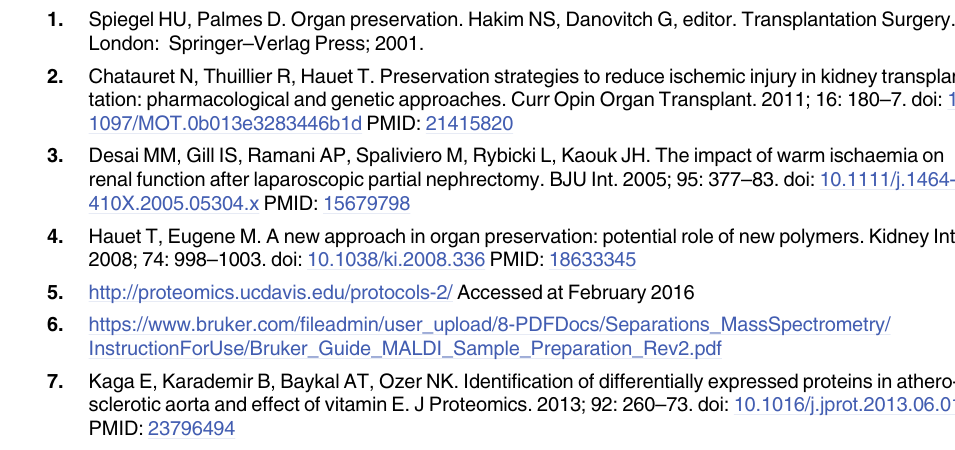
S2 Table. Receipents test results (Biochemistry and hematology). Main biochemical and hematological test results of recipients during follow up